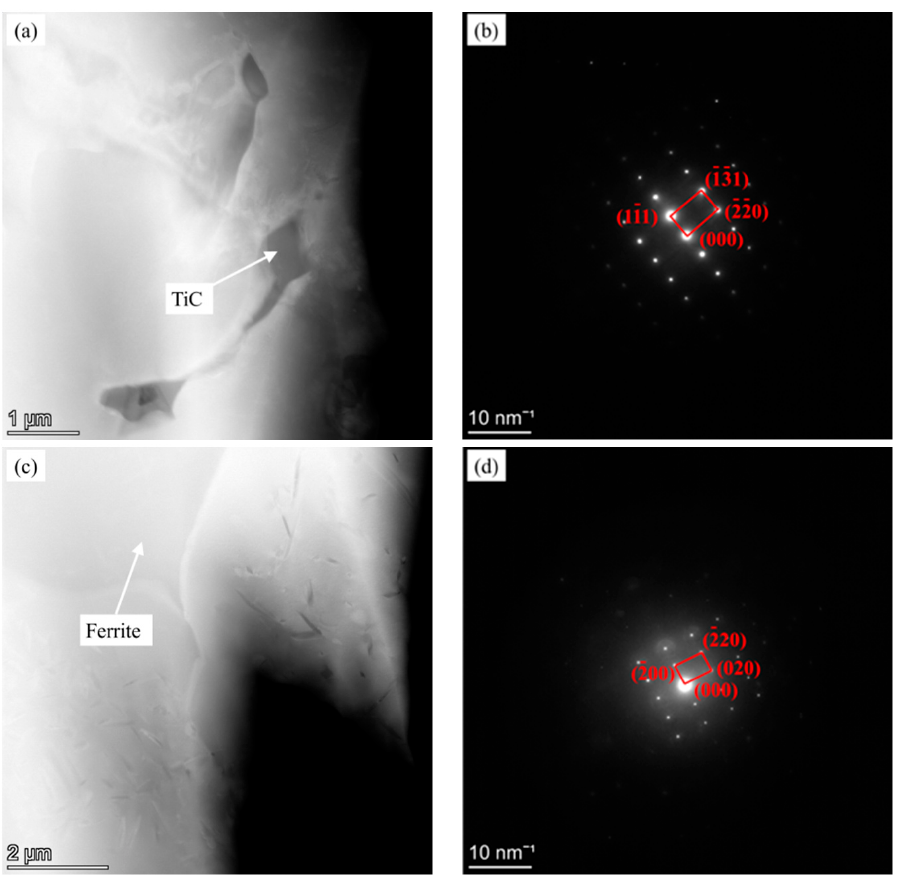
Figure 5. TEM image of Fe-25Mn-9Al-8Ni-1C-0.4Ti alloy. ( a ) BF TEM of TiC; ( b ) TiC diffraction spots ( c ) BF TEM of Ferrite; ( d ) Ferrite diffraction spots. ( c ) BF TEM of Ferrite; ( d ) Ferrite diffraction